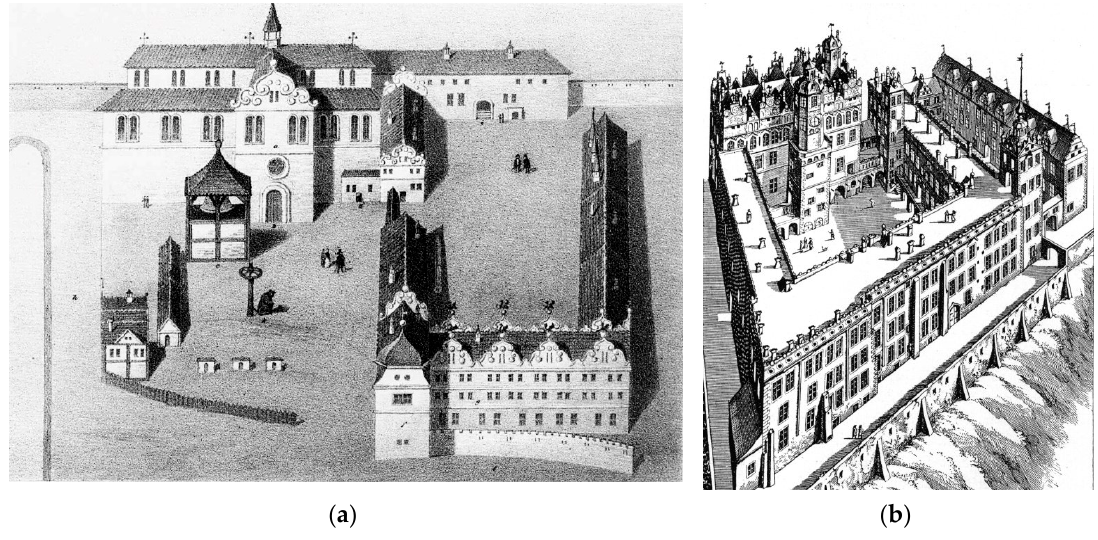
Figure 2. ( a ) The Pomeranian Dukes’ Castle in Szczecin between 1538 and 1574, source: fotopolska.eu; ( b ) Matthäus Merian, aerial view of the Pomeranian Dukes’ Castle in Szczecin, 1653, source: Wikimedia Commons.